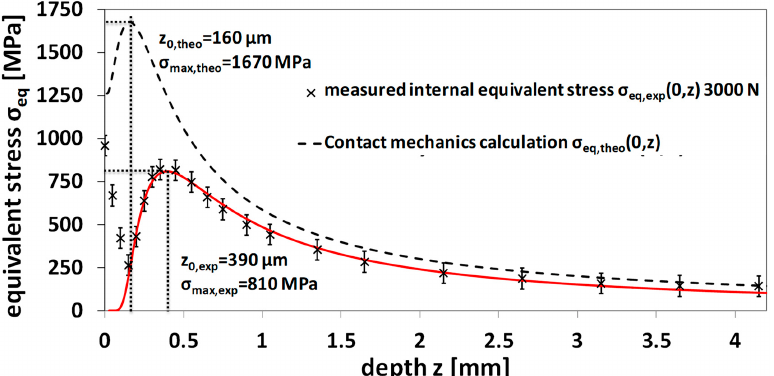
Figure 9. Comparison of experimental data of equivalent stress distribution σ eq ( y , z ) in depth at 3000 N load with theoretical elastic contact equivalent stress distribution.